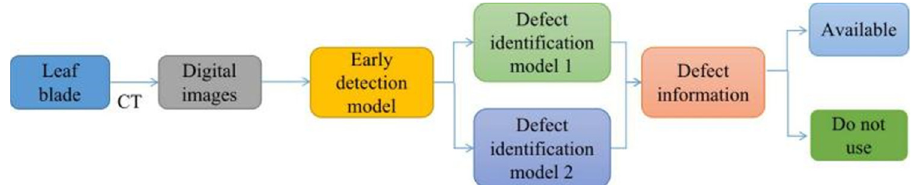
Figure 1: Expert system.